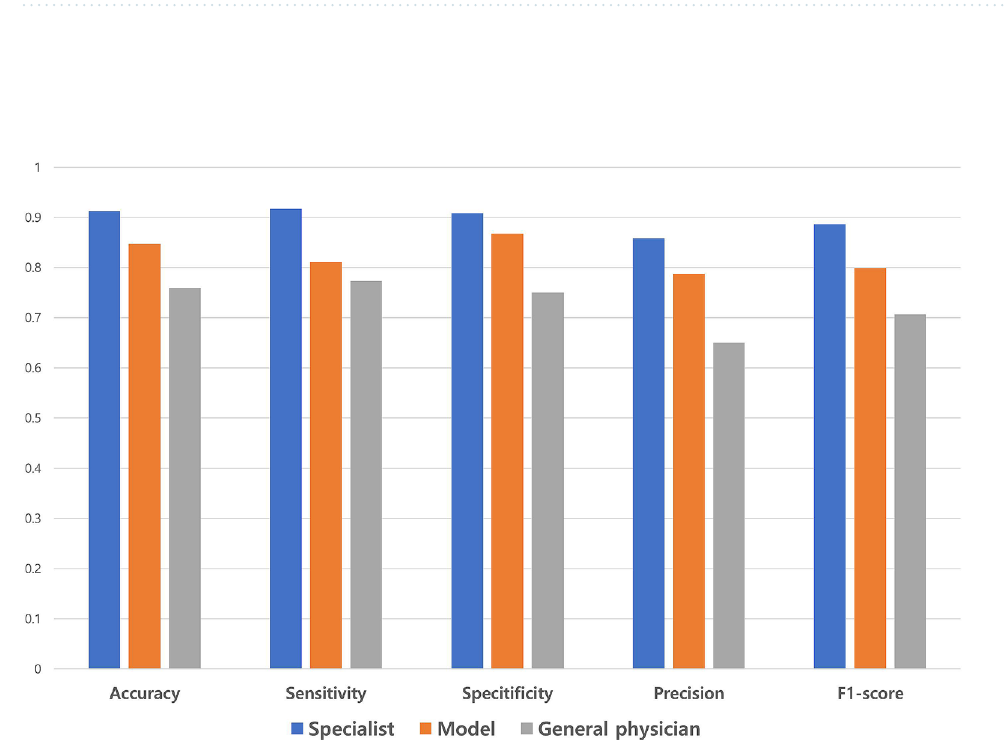
Figure 3. Performance of the deep learning model and comparison with human